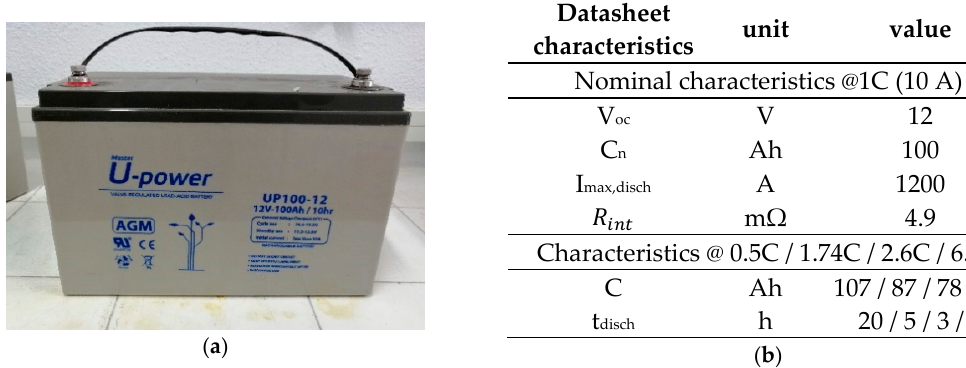
Figure 12. (a) Lead acid battery unit; (b) lead acid battery datasheet characteristics [44].